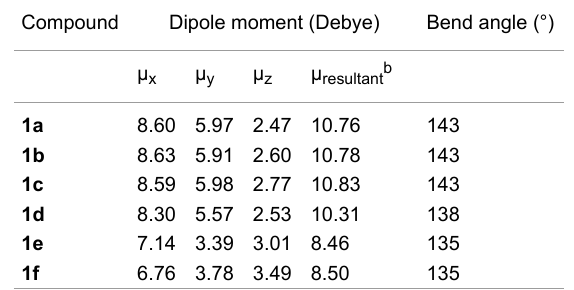
Table 2: DFT-calculated bend angle Θ , dipole-moment components ( μ x , μ y , μ z ), modulus ( μ ), and angle γ , formed with respect to the longi- tudinal axis x as shown in Figure 3. a